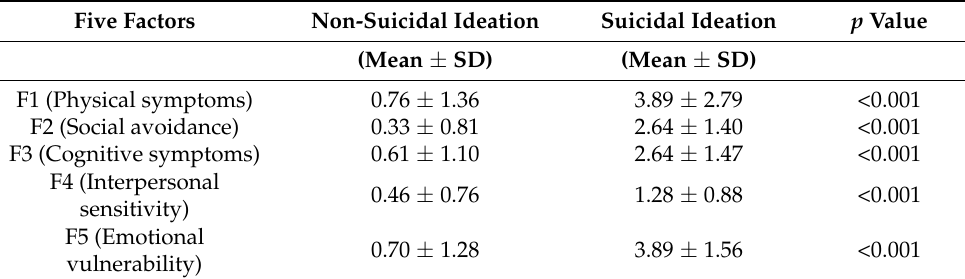
Table 3. The differences between suicidal ideation and non-suicidal ideation of the scores of five factors.